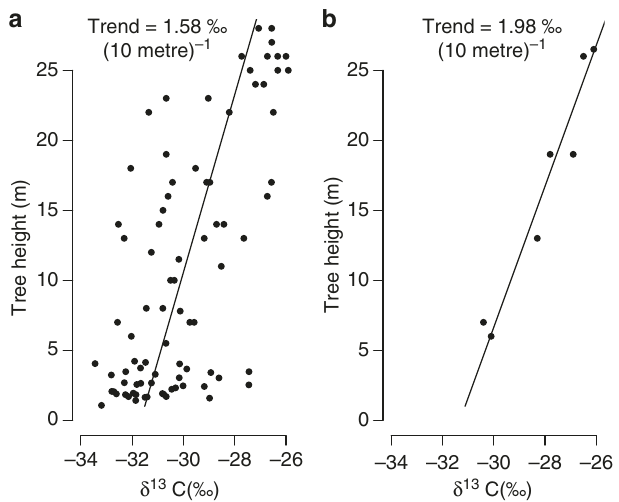
Fig. 3 Comparison of height- δ 13 C curves derived from tree ring and leaf δ 13 C -data for Fagus . Data in a are from this study (i.e., bulk samples of the last fi ve rings from different sized trees). Leaf data in b are from Schleser 56 , collected at different heights in the canopy from a single Fagus tree in